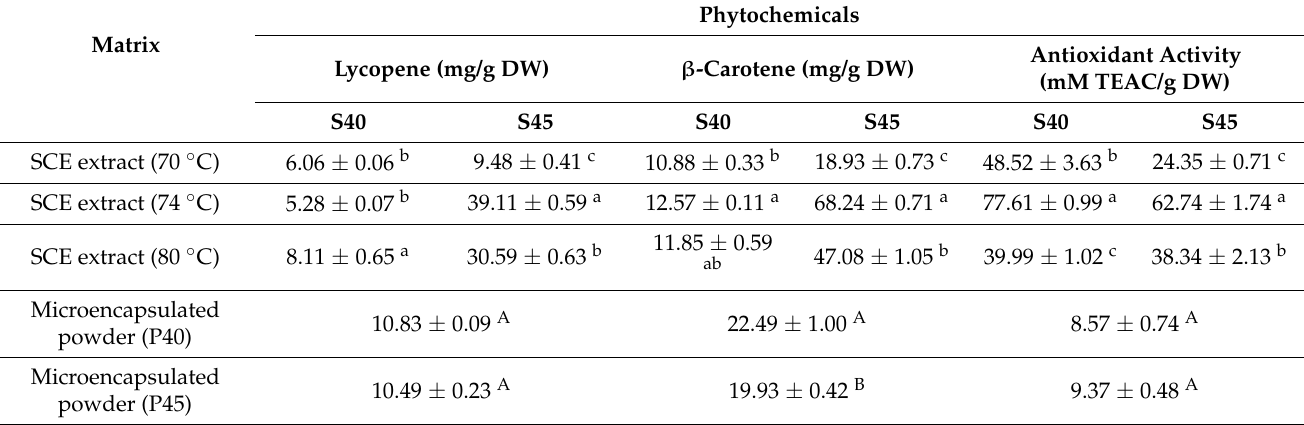
Table 1. The phytochemicals content of the extracts, obtained in different separators (S40 and S45) and the corresponding microencapsulated